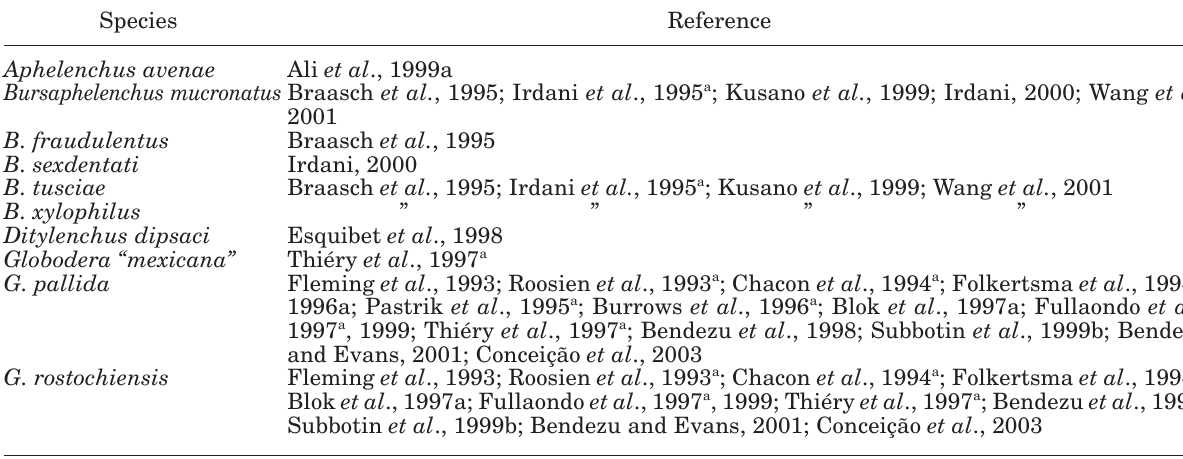
Table 9. Plant-parasitic nematodes species characterized by RAPD-PCR.